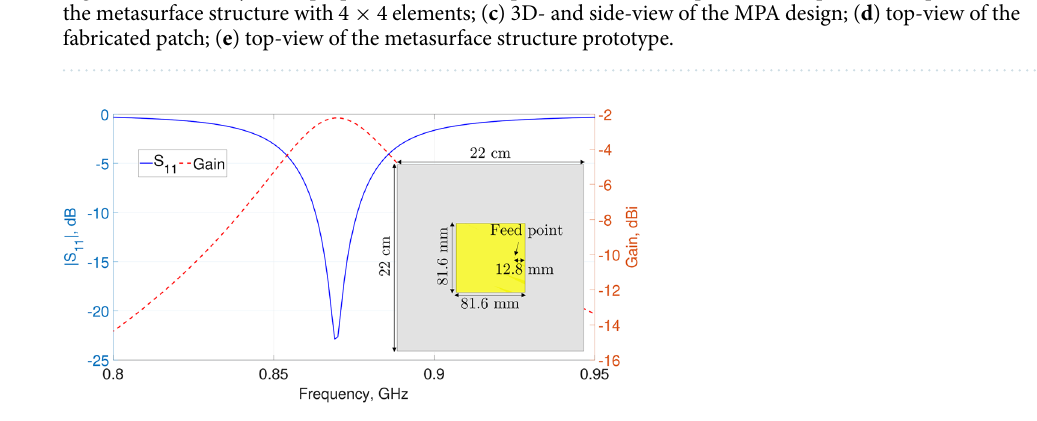
S 11 and realized gain of a typical patch antenna operating at 868 | |